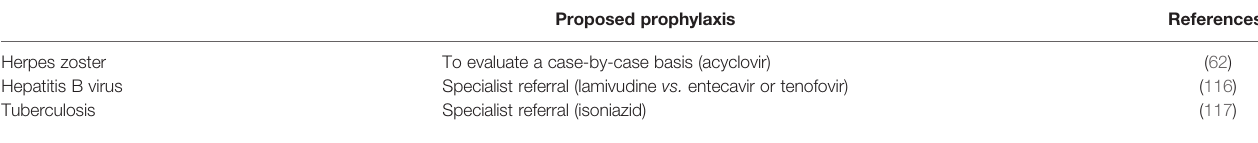
TABLE 3 | Proposal for the most frequent antiviral and antibiotic prophylaxis for ruxolitinib-treated MPN patients.